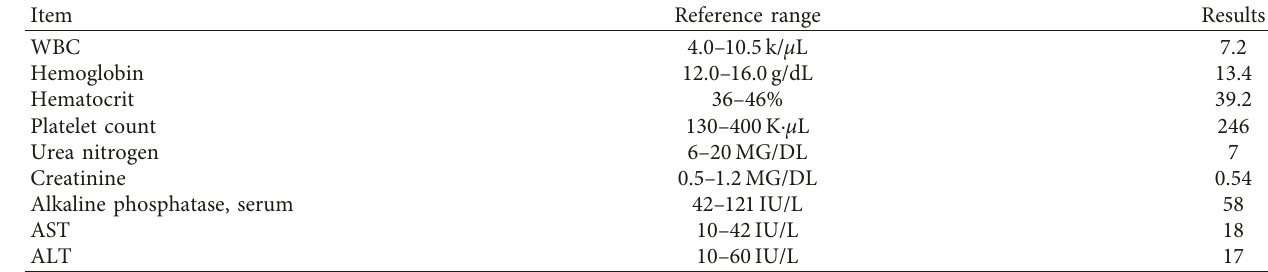
Table 1: Component of complete blood count and metabolic panel.